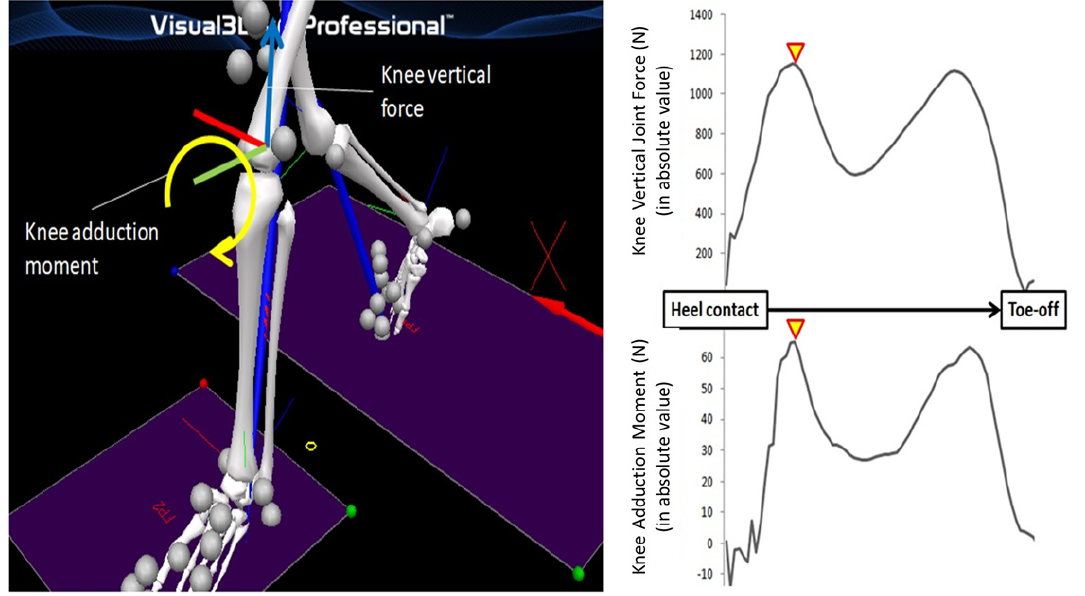
Figure 1. Knee adduction moment and vertical force, the first peaks as highlighted. Both parameters indicated in absolute value.